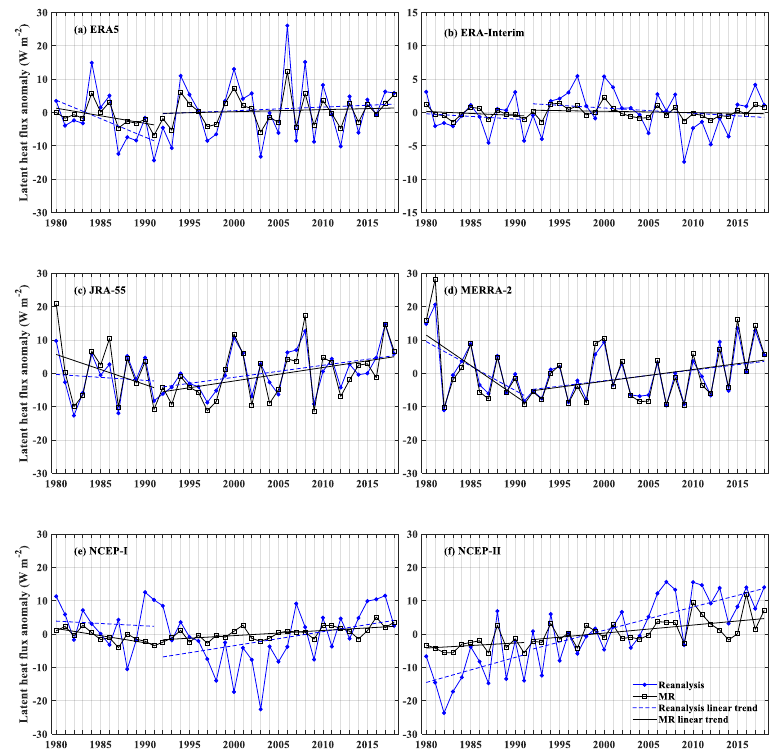
Figure 4. The temporal series of the summer reanalysis LE and MR LE anomalies at the Ali site from 1980 to 2018 and their linear trends.